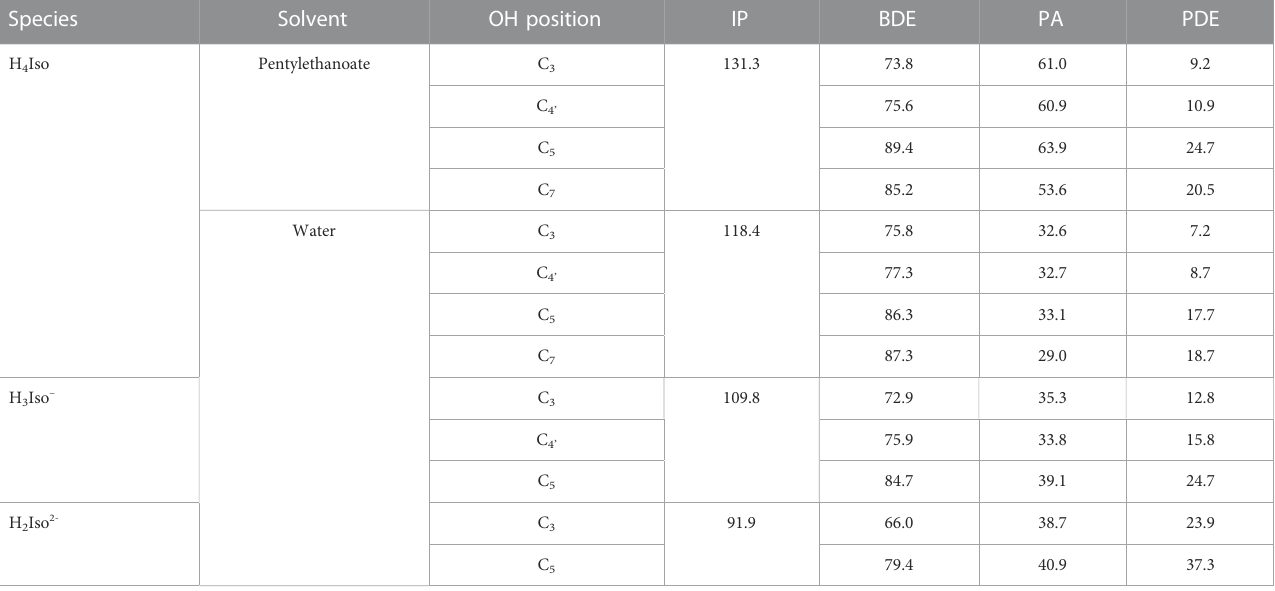
TABLE 1 IP, BDE, PA, and PDE values calculated for neutral and charged isorhamnetin species in water and pentylethanoate solvents. All values are in kcal/mol.